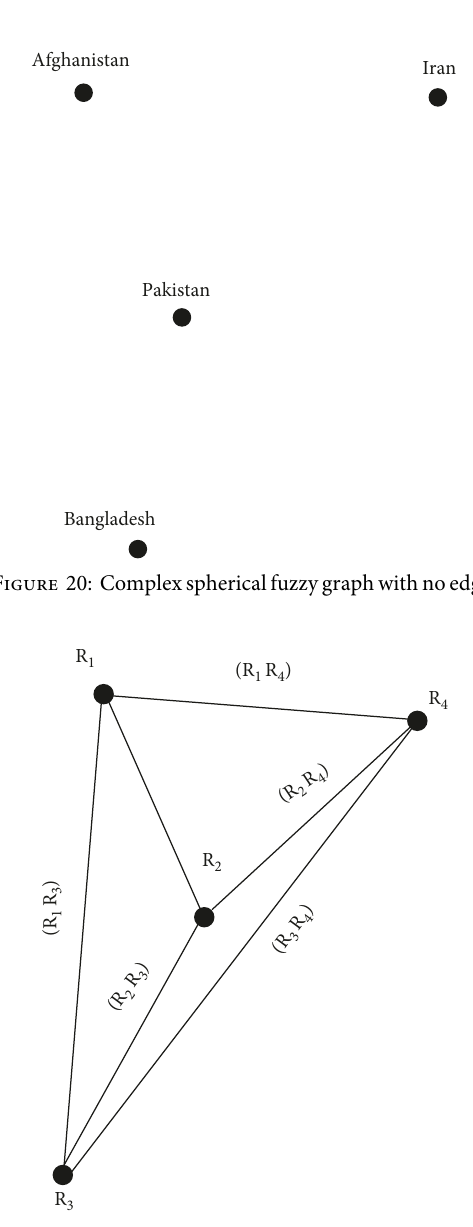
Figure 21: Complexspherical fuzzy graph with